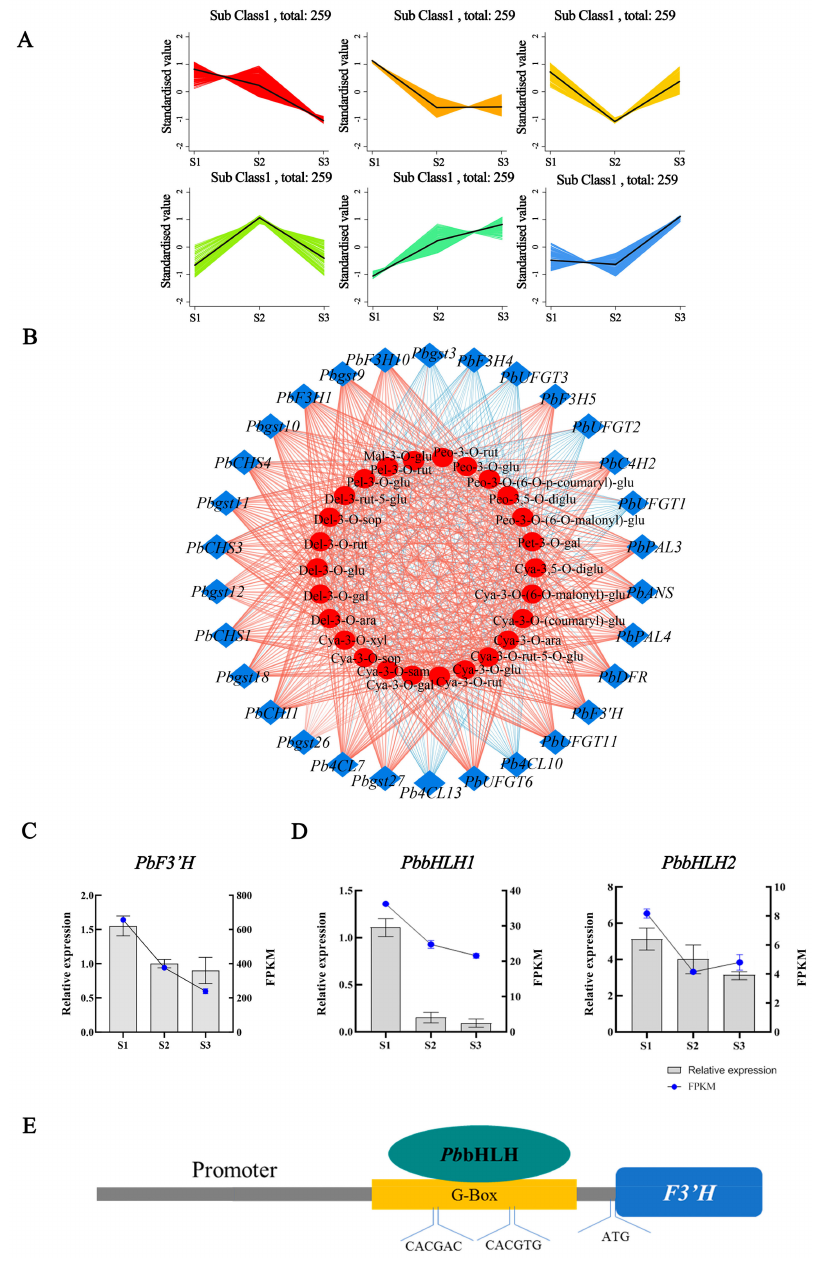
Figure 6. Comprehensive analysis of the transcriptome and metabolome and identification of key structural genes and transcription factors. ( A ) Six subclasses of co-expressed genes and their kinetic patterns during leaf development. ( B ) Correlation analysis of DEGs and differentially expressed metabolites (DAMs). The red line indicates a positive correlation, and the blue line indicates a negative correlation. The line thickness represents the correlation index, and correlations with R > 0.8 and p < 0.05 were deemed significant. ( C , D ) The expression patterns of PbF3 (cid:48) H , PbbHLH1 , and PbbHLH2 between leaves in three developmental stages were evaluated. Quantitative Real-time PCR (expression levels were calculated for PbF3 (cid:48) H , PbbHLH1 , and PbbHLH2 and EF1 α expression was used for normalization in P. bournei . Each value is the mean of three replicates, and the error line indicates the standard deviation. ( E ) Analysis of cis-acting elements of the promoter of PbF3 (cid:48) H in P. bournei